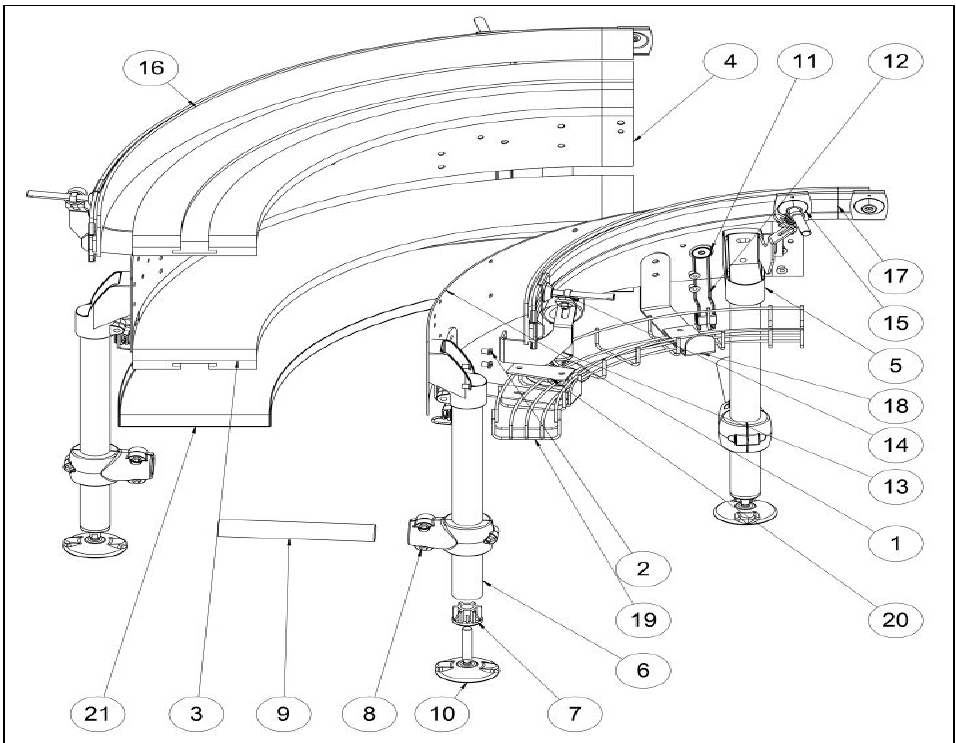
Figure 7. Exploded diagram for ’90-degree curve section’.